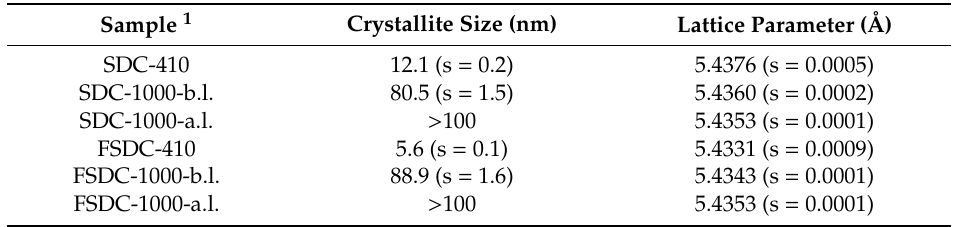
Figure 2. XRD patterns of the ( i ) FSDC powders after self-ignition at 410 ◦ C (bottom, black), ( ii ) FSDC / MgO pellet after sintering at 1000 ◦ C (middle, maroon) and ( iii ) same pellet after MgO leaching (top, red). Patterns are stacked. Table 2. Lattice parameters and crystallite sizes of the SDC and FSDC powders and pellets obtained from the Rietveld refinement of the XRD